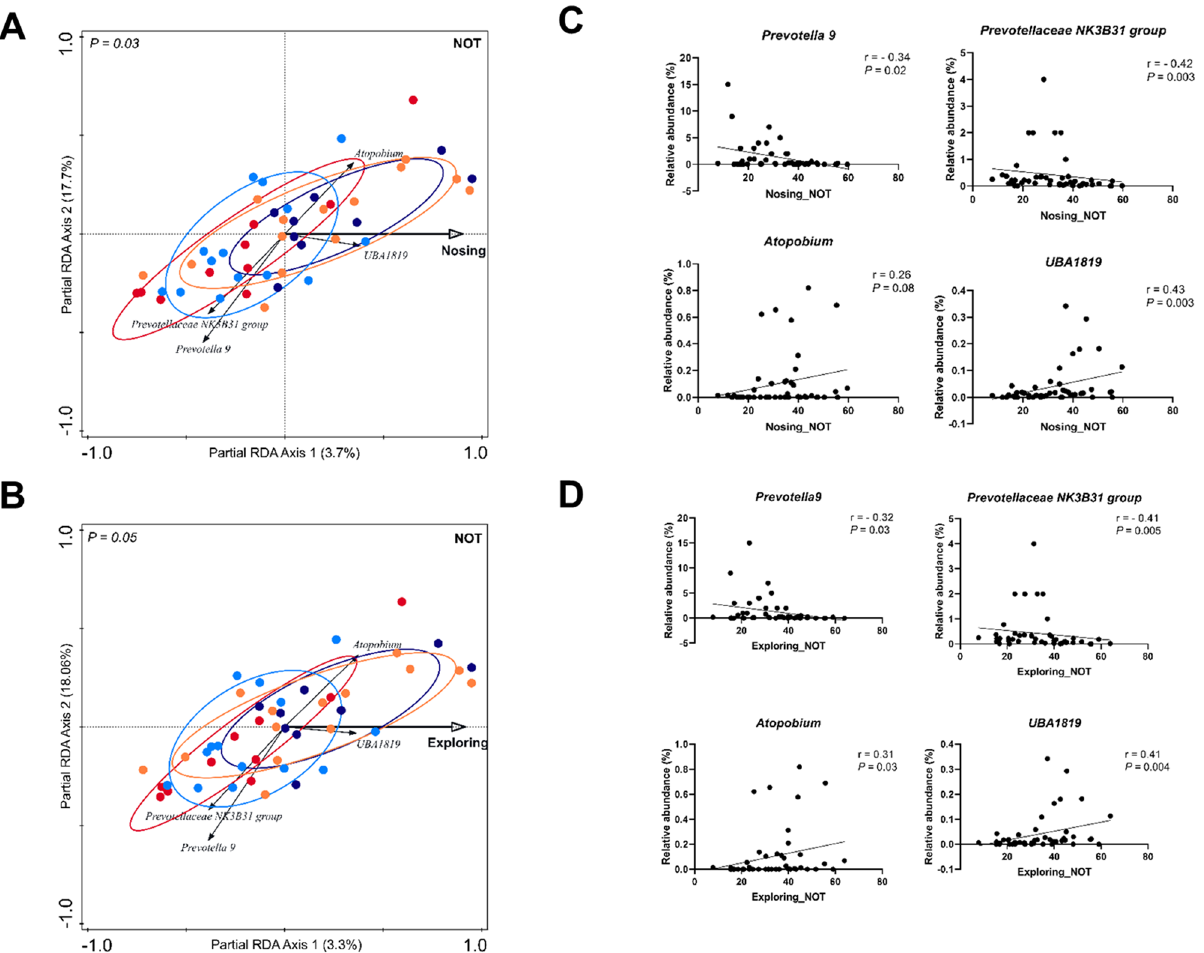
Figure 3. Assessing microbial associations of individual behavioural variables in novel object test (NOT). ( A ) Partial redundancy analysis (pRDA) of the nosing behaviour (% of time spent nosing) during the novel object test, corrected for experiment and treatment. ( B ) pRDA of the exploring behaviour (nosing + rooting: both walls and floor; % of time spent exploring), corrected for experiment and treatment. In the pRDA triplot, individual animals are indicated in coloured balls belonging to either one of the experiments and treatment group. Microbial groups having (1) RDA response score ≥ 0.35 as well as (2) minimum 0.1% relative abundance in at least 10% of the samples, are visualised in the triplot. The perpendicular distance between microbes and environmental variable axes in the plot reflects their correlations. The smaller the distance, the stronger the correlation. ( C ) Spearman correlation of pRDA identified microbes with nosing behaviour. ( D ) Spearman correlation of pRDA identified microbes with exploring